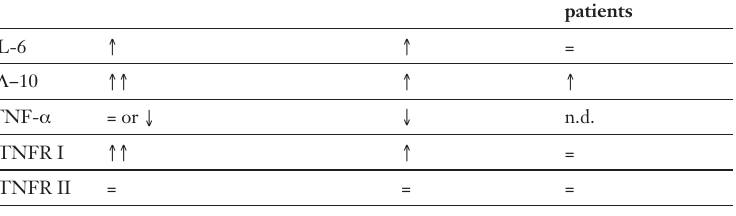
Cytokine levels in healthy pregnant women, SLE patients, and SLE pregnant patients compared with those observed in healthy non pregnant women. Healthy pregnant women SLE patients SLE pregnant